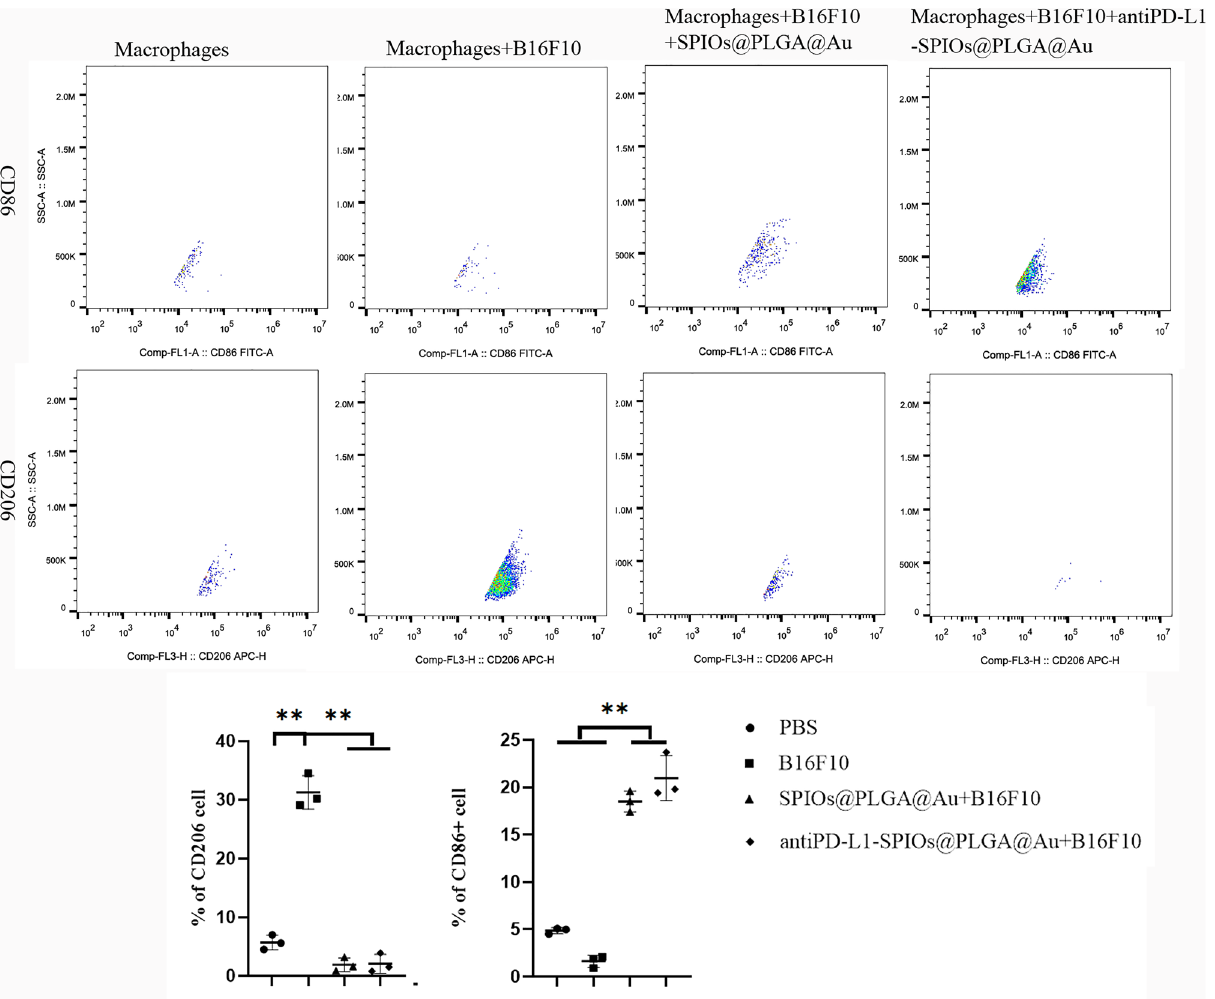
Figure 5. Flow cytometry of M1 and M2 macrophages after co-culture with different culture components (** P <